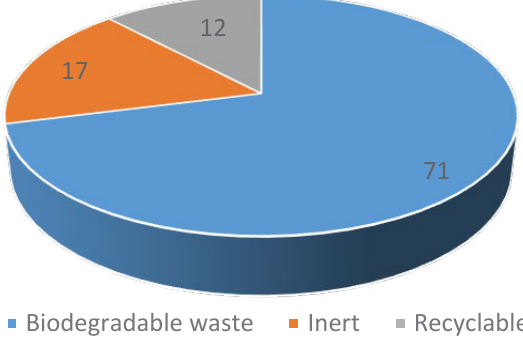
Fig. 4: Physical characterization of solid waste in Gurugram